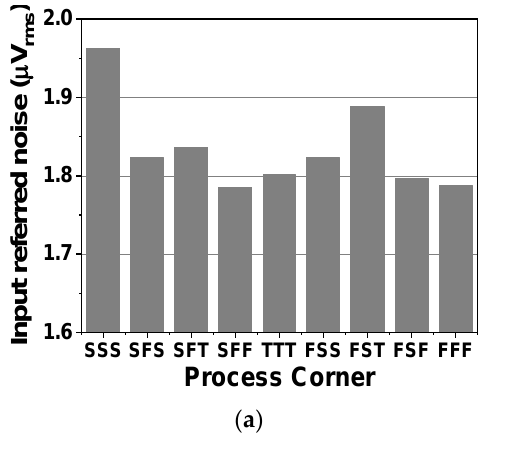
Figure 12. The input referred noise of the proposed CCIA: ( a ) Depending on the process corners; ( b ) Monte Carlo simulation results. ( b ) Monte Carlo simulation results.